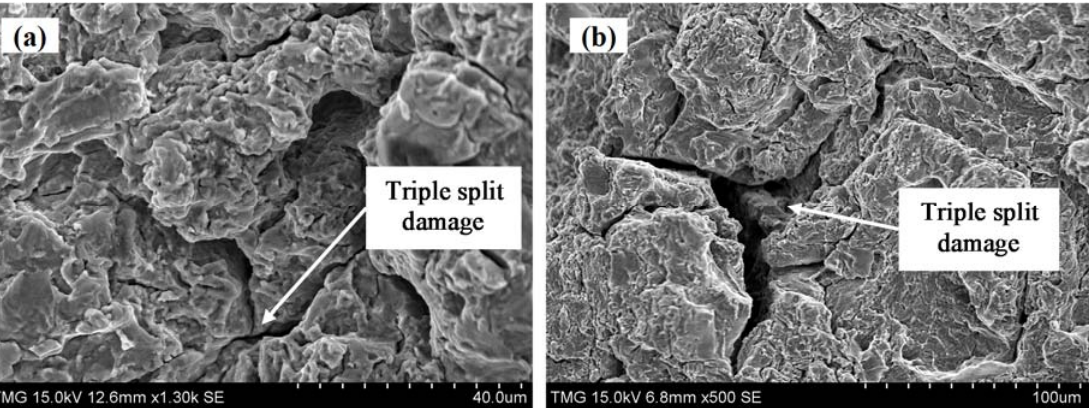
Figure 26. Triple split damage on ( a ) non-treated Ti64; and ( b ) DR-treated samples.